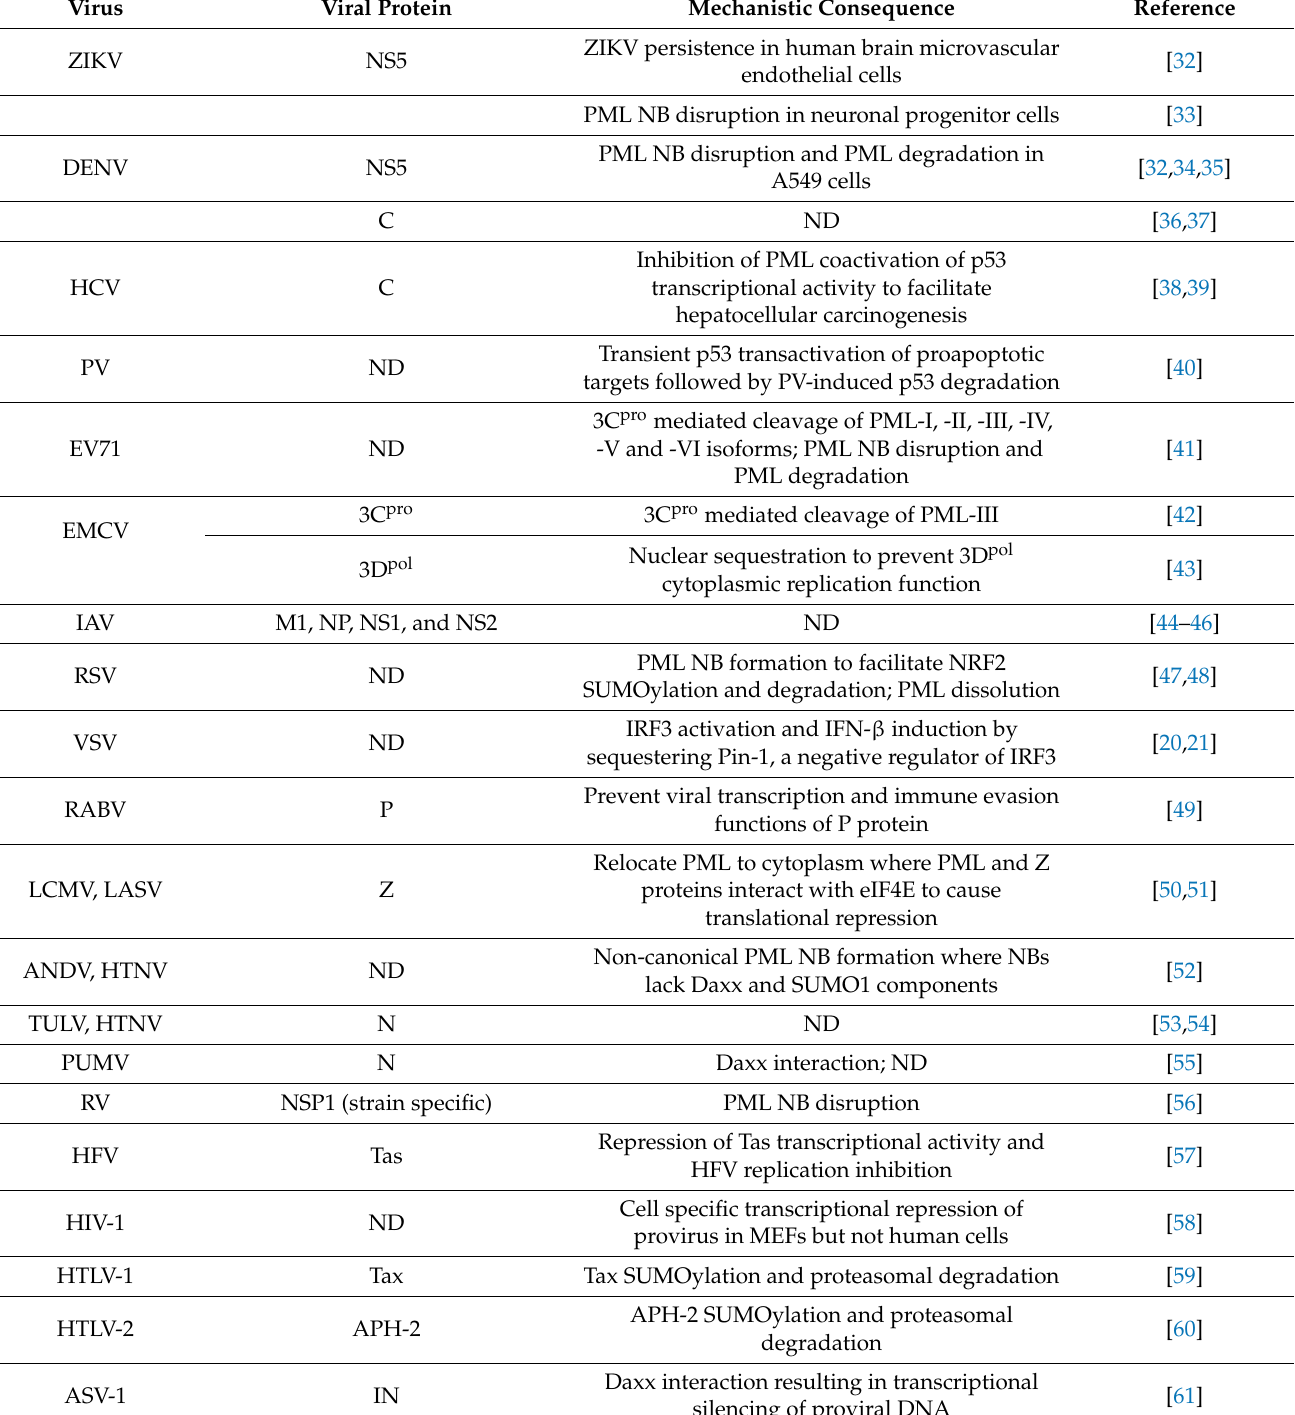
Table 1. Viral proteins interacting with Promyelocytic leukemia nuclear bodies and its